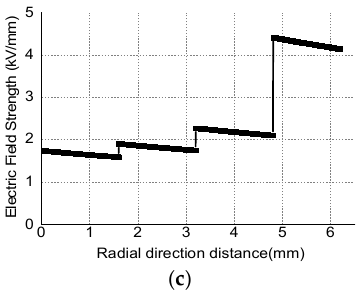
Figure 1. The capacitor core model of oil-impregnated paper (OIP) bushing. ( a ) Structure of bushing model; ( b ) Capacitance core; ( c ) Radial direction electric field.